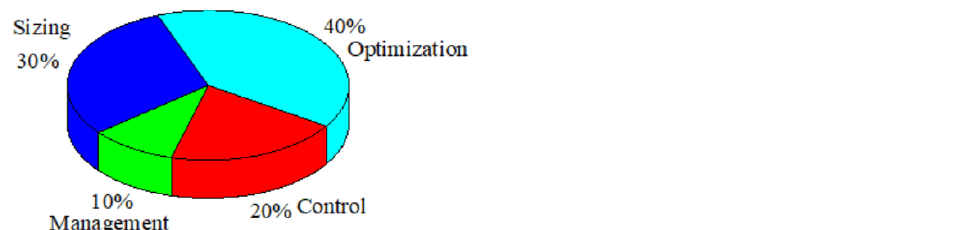
Figure 1. ( a , b ) An HRES optimization methodology.